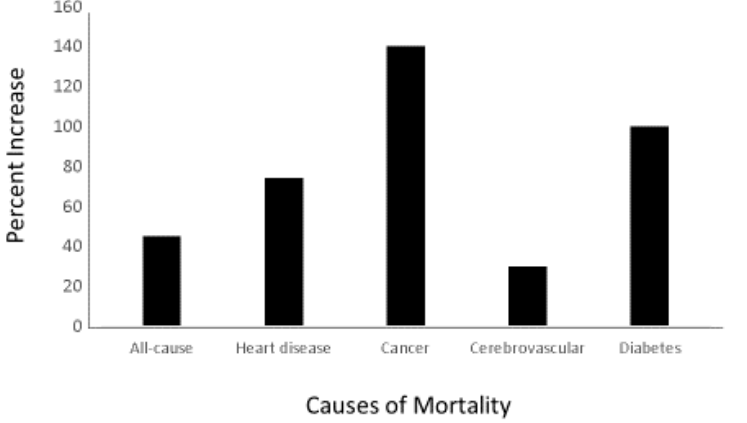
Figure 3. Percentage Increase in Cause-Specific Mortality for Black compared to White Americans, Ages 50–64 years—United States, 2015 [150].